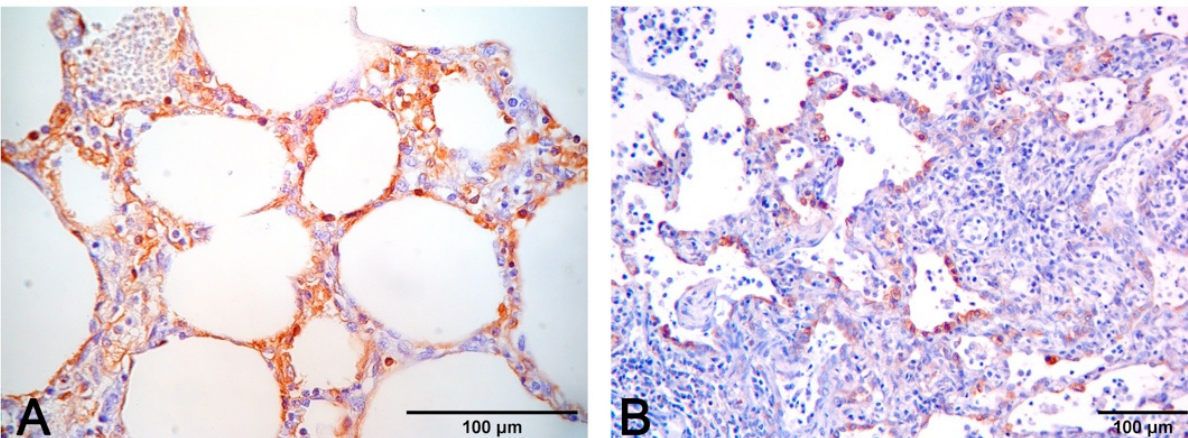
Figure 10. ( A ) Immunohistochemical stain to PCV2 (monoclonal antibody anti-PCV2, clone F217) with positive macrophages in alveolar septa. ( B ) Immunohistochemical stain to PRRSV (monoclonal antibody anti-PRRSV, clone SDOW17-A) with positive hyperplastic type II pneumocytes and rare interstitial machrophages.